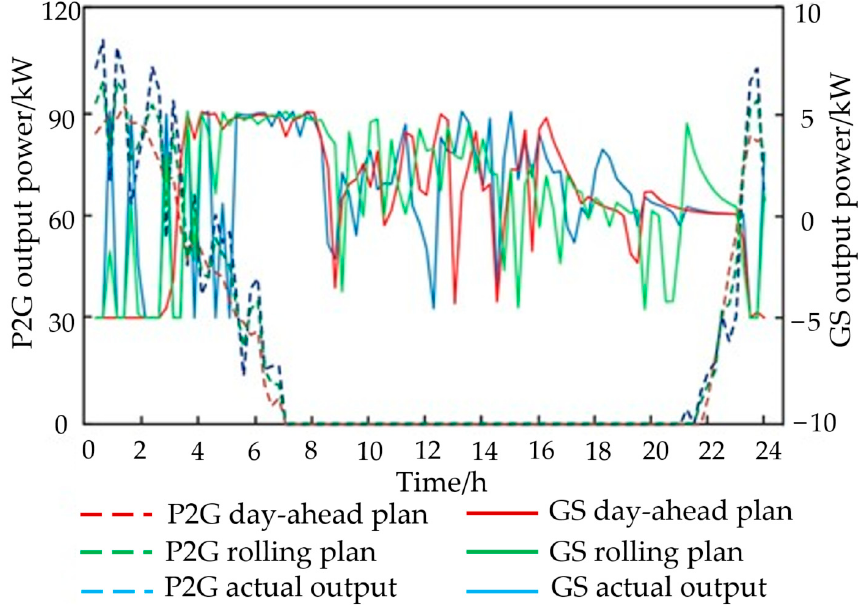
Figure 10. Comparison of advance plan, rolling plan and actual output of P2G and gas storage de- vice.